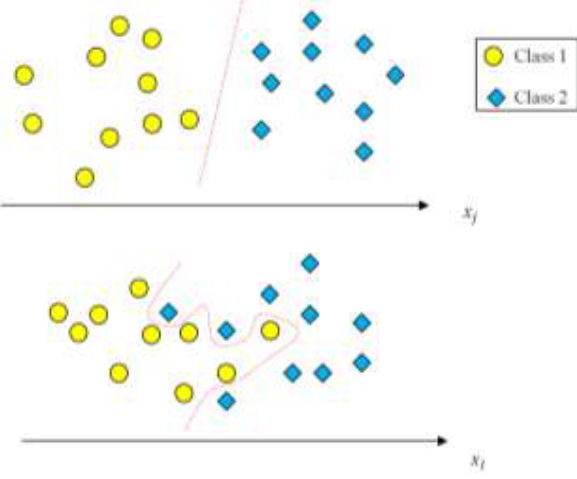
Figure 1. Samples of two classes in a two-dimensional feature space. Figure 2. There is not overlap between classes in band 𝒙 𝒋 , and so two classes are easily separated from each other in 𝒙 𝒋 while there is overlap between classes in band 𝒙 𝒍 , and so two classes are hardly separated from each other in 𝒙 𝒍